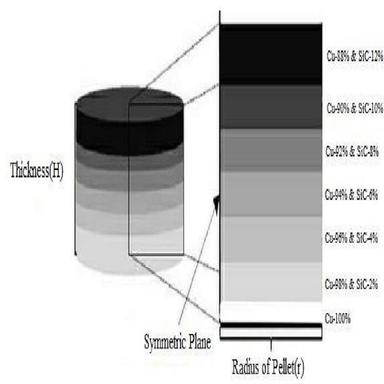
Layers of FGM.